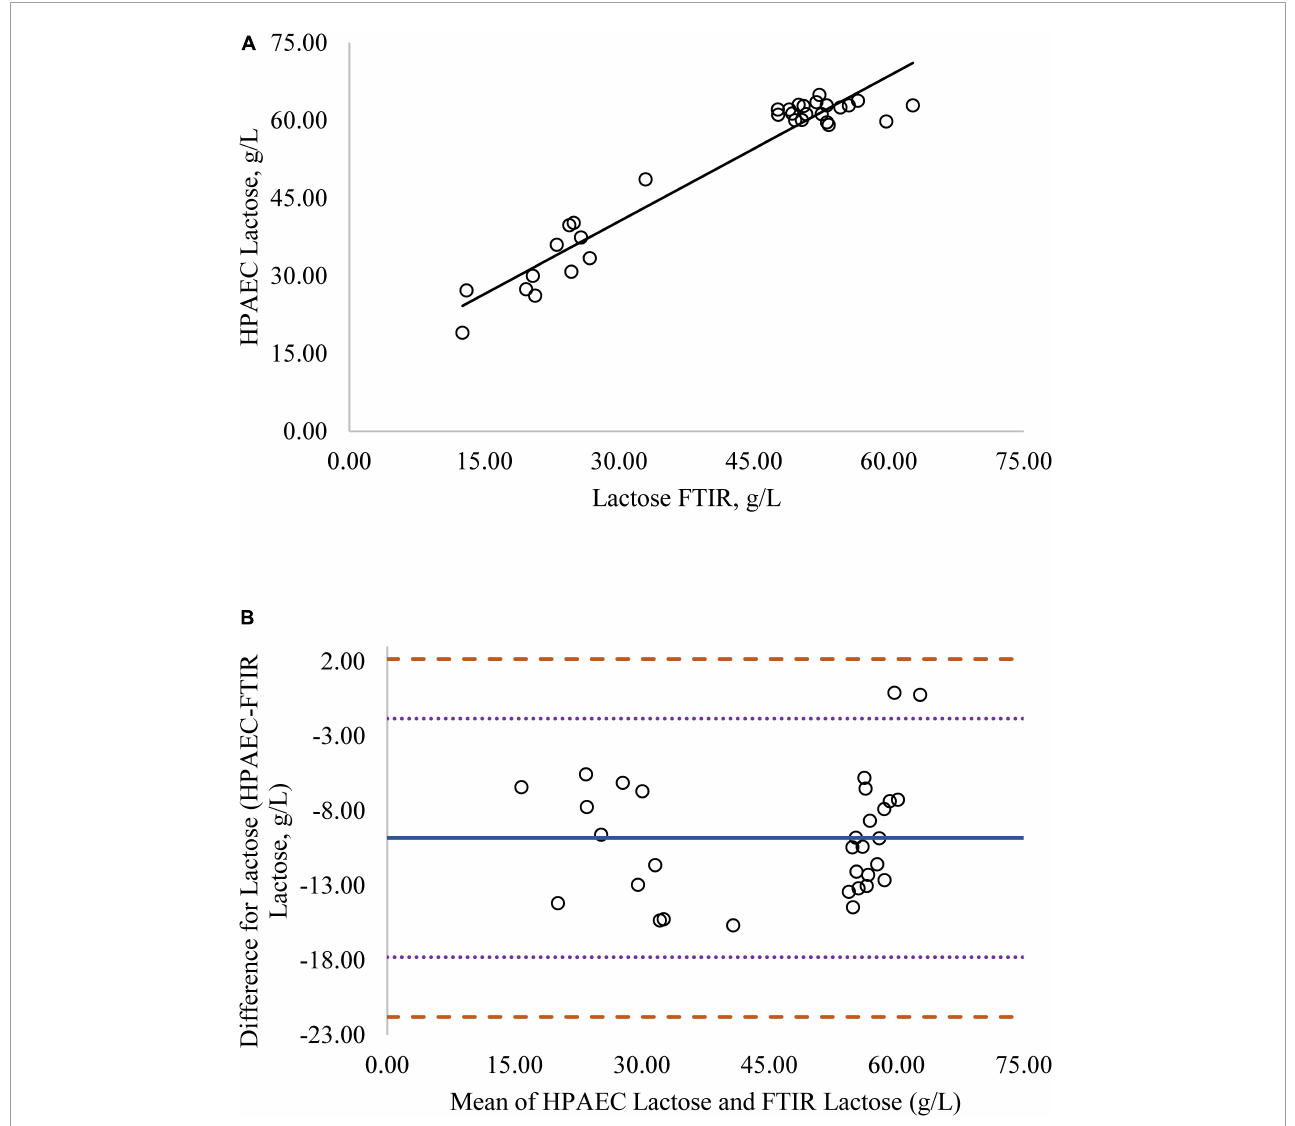
FIGURE3 (A) Mare milk lactose concentration measured by FTIR and High Performance Anion Exchange Chromatography (HPAEC) method. Correlation graph between the two methods for lactose, r 2 = 0.93, P < 0.0001. Regression model y = 0.950X + 11.837. (B) Mare milk lactose concentration measured by FTIR and HPAEC method. Bland-Altman plot showing the mean differences and limits of agreement. Bias line: solid line, two standard deviation (s.d.): dotted lines, three s.d.: dashed lines.